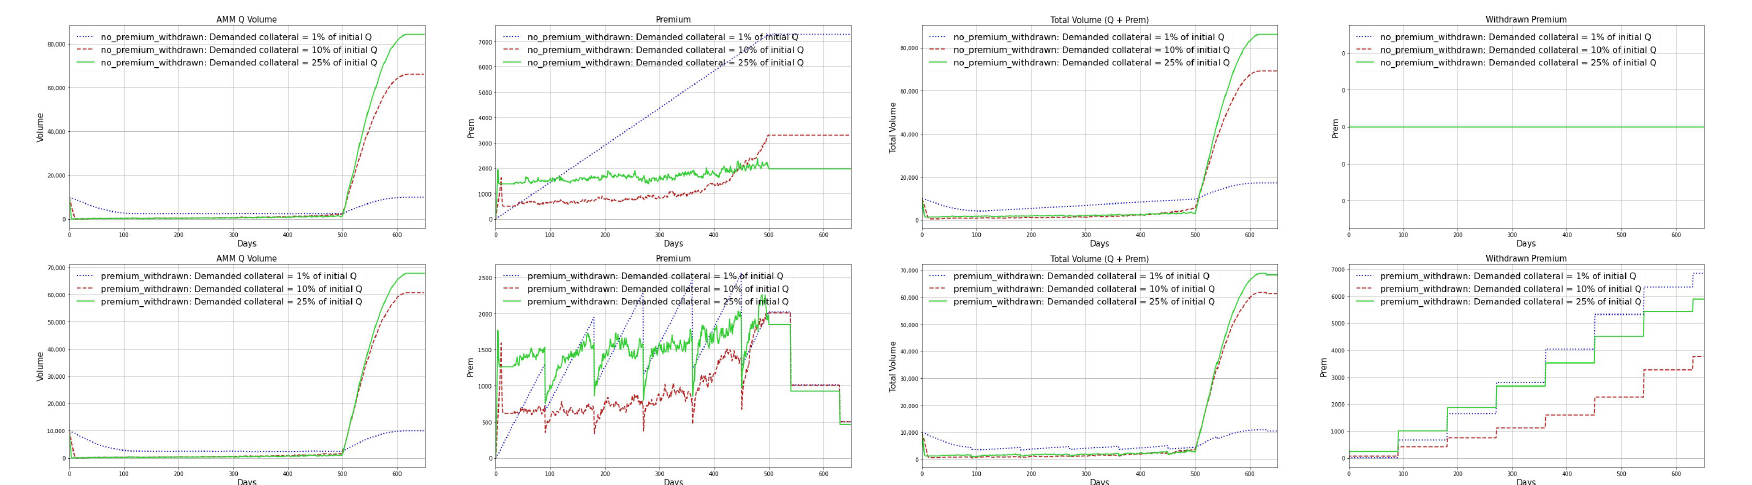
Figure A12. rkAMM Curves from simulation of scenario 4 and 90 days of withdrawal